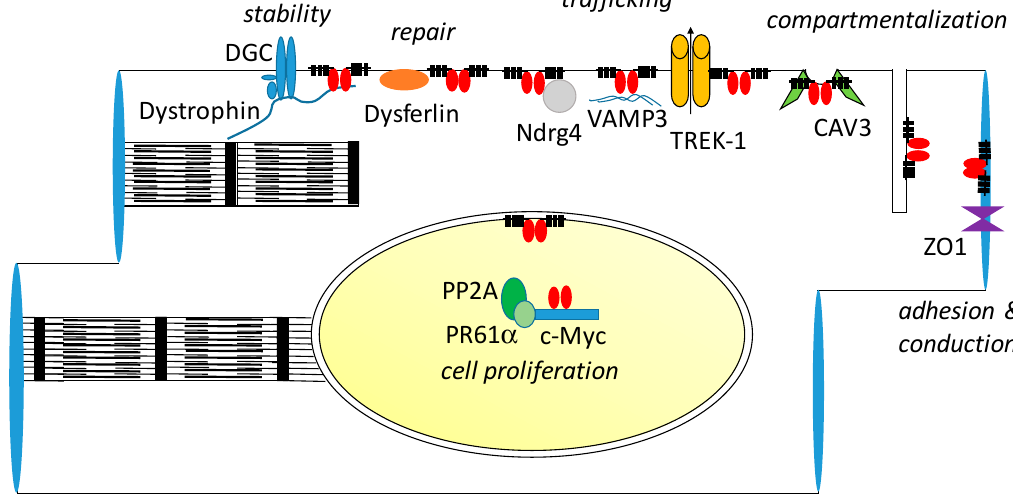
Figure 4. POPDC proteins participate in multiple protein complexes and subcellular compartments. Shown here is a schematic depiction of the different protein complexes of which POPDC1 is a part. Most of the interacting proteins are localized to the sarcolemma. However, Popdc1 and Popdc2 are also localized to specialized membrane compartments, such as caveolae, t-tubuli, nuclear envelope, nucleoplasm and intercalated disk. While a ventricular cardiac myocyte has been depicted here, some of the protein complexes have not been characterized in this cell type. The interacting proteins in the nuclear envelope and t-tubules have not yet been identified.